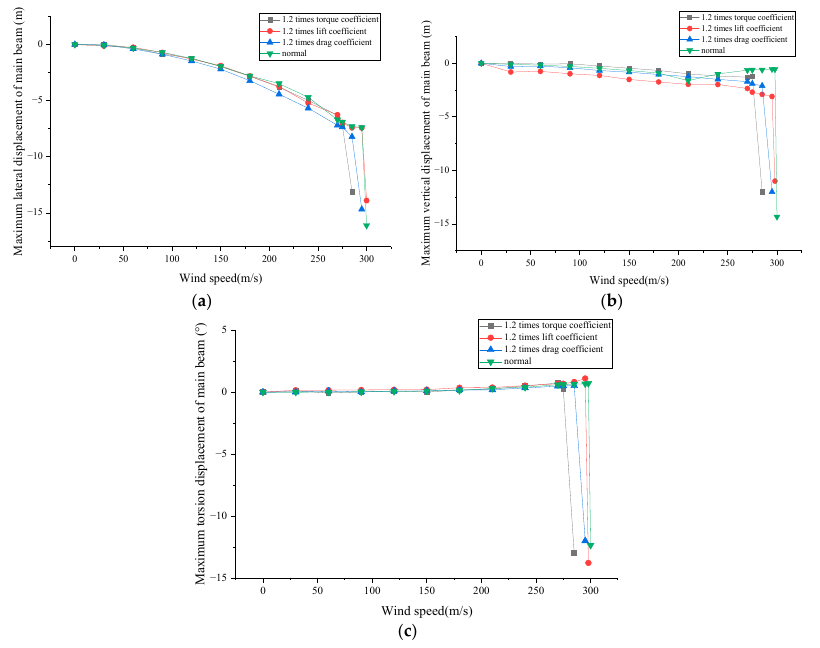
Figure 14. Maximum displacement curve of main beam with wind speed under different three- component force coefficients; ( a ) Lateral displacement; ( b ) Vertical displacement; ( c ) Torsion angle.